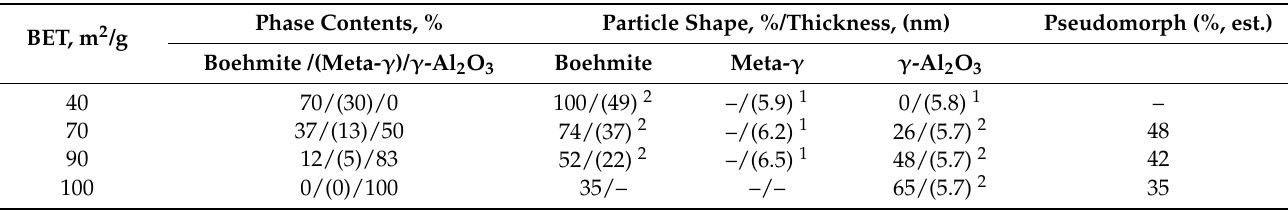
Table 3. Property variations of calcined boehmite